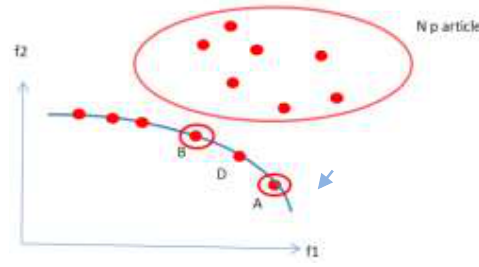
Figure 2. Leader selection (2 nd approach).